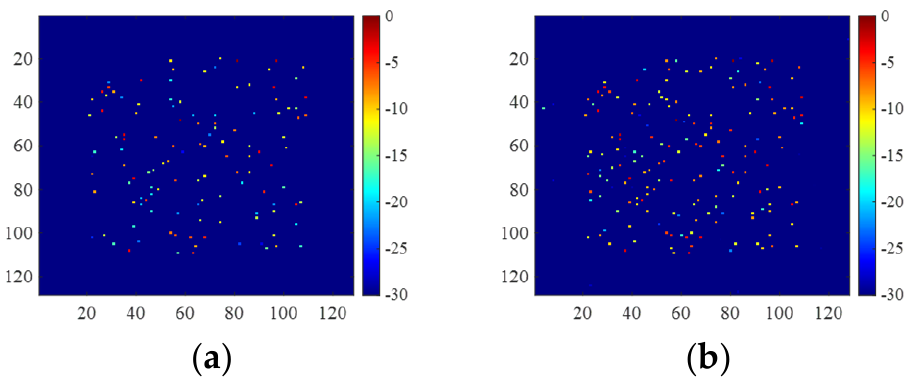
Figure 19. Images obtained by ( a ) optimal 2D-ADMM and ( b ) trained 2D-ADN. Table 11. Quantitative performance evaluation for different methods. Table 12. Quantitative performance evaluation for different methods.